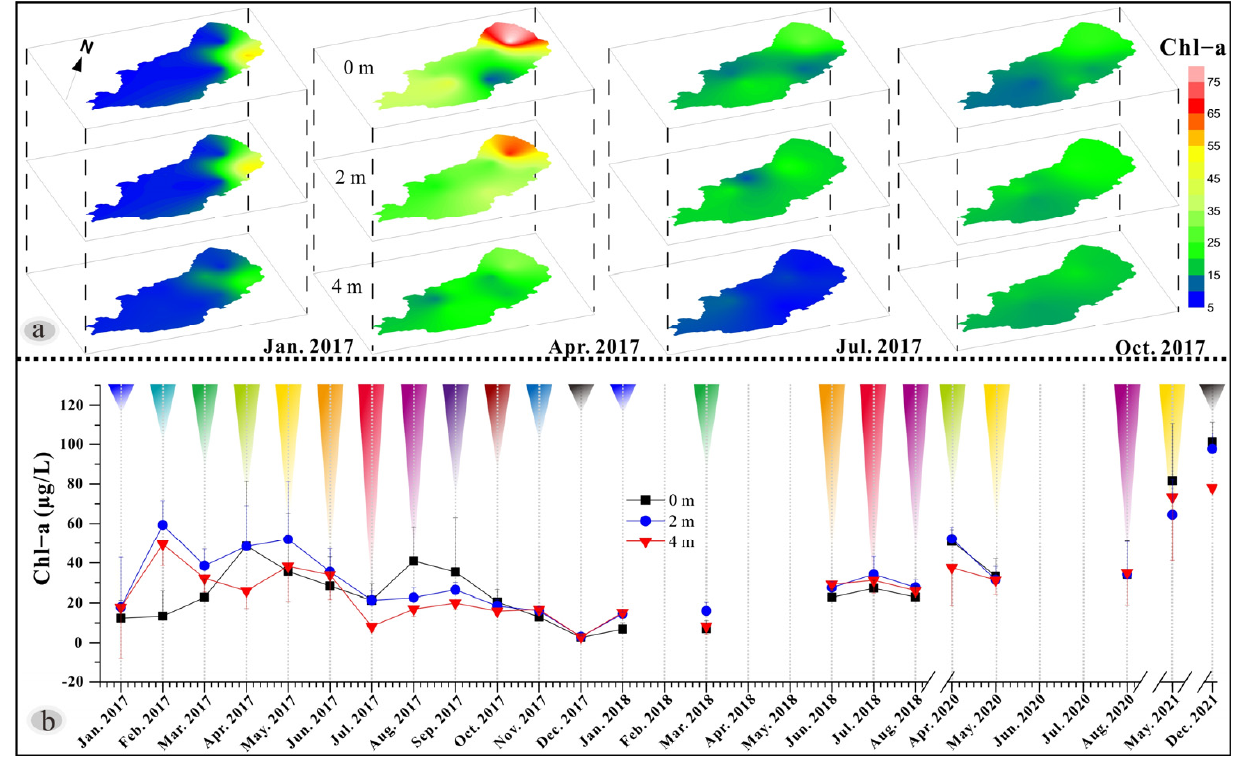
Figure 6. Seasonal and annual variations in Chl-a in Lake Qilu. ( a ) Temporal and spatial variation characteristics in Chl-a; ( b ) Interannual variations in Chl-a .